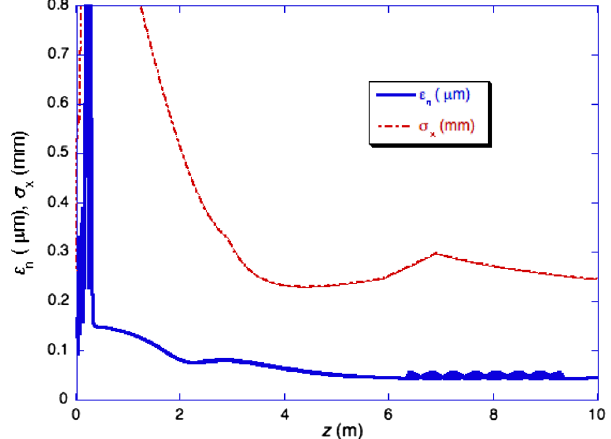
FIG. 7. Evolution of transverse beam size and normalized emittance in S-band photoinjector, with 1.45 cell rf gun operated at 250 MV = m followed by two 3-m traveling wave linac sections, using cigarlike beam with 200 pC charge and 10 ps FWHM bunch